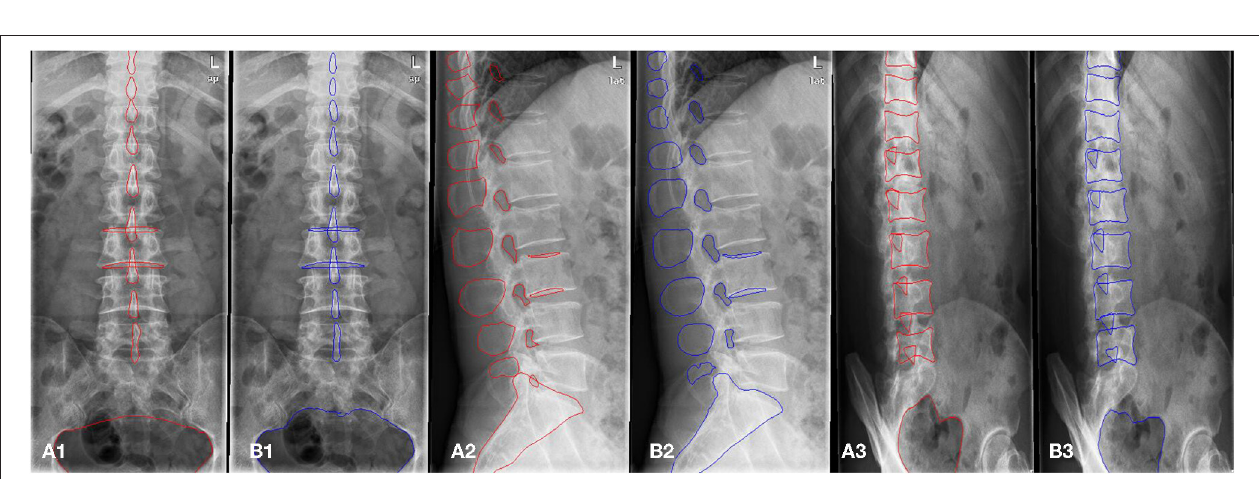
FIGURE 3 | The example of manual segmentation and AI segmentation for three positions, anteroposterior (A1,B1) , lateral (A2,B2) and oblique view (A3,B3) . (A1,A2,A3) Ground truth of segmentation by manual marking. (B1,B2,B3) AI segmentation results.